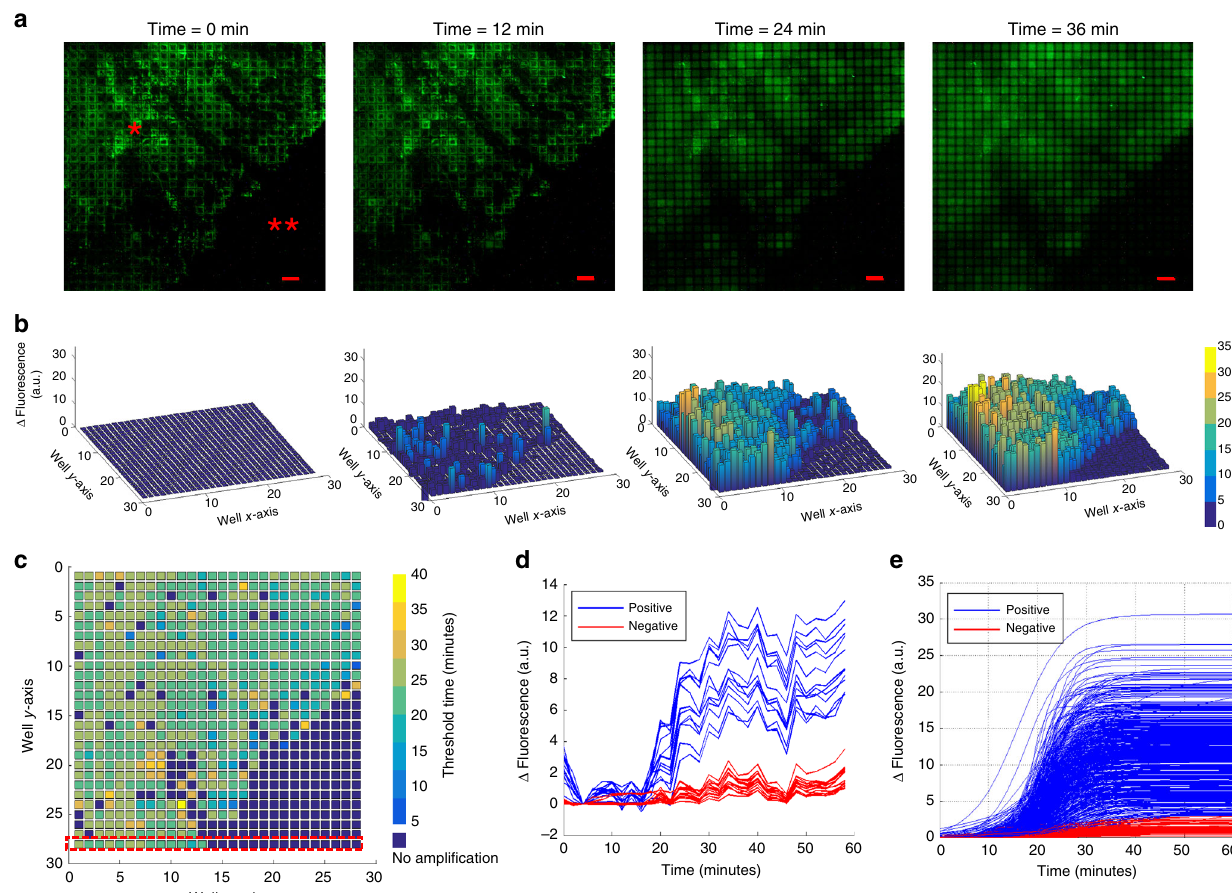
Fig. 4 On-chip RT-LAMP for TOP2A mRNA. a Raw fl uorescence images of real-time RT-LAMP with tissue on chip at four different time points (*Tissue, **No tissue) (scale bar: 200 µ m). b Fluorescence bar graphs of the raw images showing a differential increase in fl uorescence over time. The gain in fl uorescence over time is calculated taking time = 0 image (initial) as the reference. c Spatial threshold analysis showing the spatially mapped threshold times. Note that the tissue boundaries are maintained throughout the reaction. Each pixel is 100 µ m × 100 µ m. d Raw ampli fi cation curves of a row marked in red in “ c ” showing positive and negative wells. e Fluorescence curves for all wells after curve fi